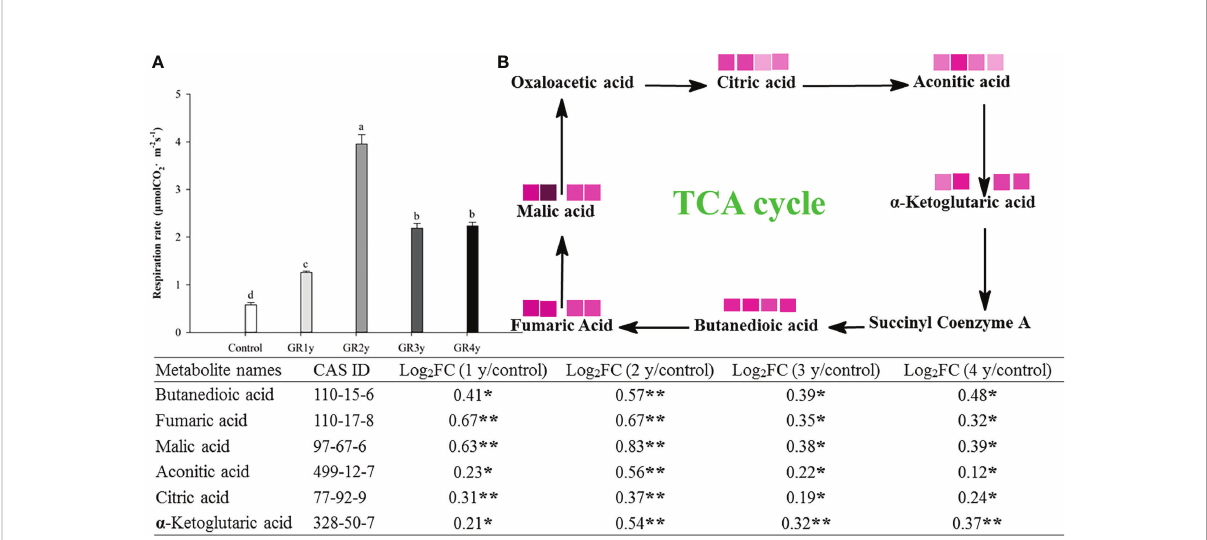
FIGURE 5 Effect of grazing rest during the spring regreening period on respiration of degraded alpine meadows vegetation dominant grass Elymus nutans Griseb. (A) Effect of grazing rest during the spring regreening period on respiration rate of Elymus nutans Griseb. (B) Effect of grazing rest during the spring regreening period on metabolite contents in TCA Cycle of Elymus nutans Griseb. Bars represent SEs. Common letters above columns indicate no signi fi cant difference at P = .05. FC means fold change of relative content. * indicate signi fi cant difference at P = .05. ** indicate signi fi cant difference at P = .01. GR 1y, GR 2y, GR 3y and GR 4y mean grazing rest for 1 year, 2 years, 3 years and 4 years respectively. represent Log2FC ≤ 0.7, ≤ 0.6, ≤ 0.5, ≤ 0.4, ≤ 0.3, ≤ 0.2, ≤ 0.1 and ≤ 0.05 respectively. represent log2FC ≤ 0.7, ≤ 0.6, ≤ 0.5, ≤ 0.4, ≤ 0.3, ≤ 0.2, ≤ 0.1, and ≤ 0.05,